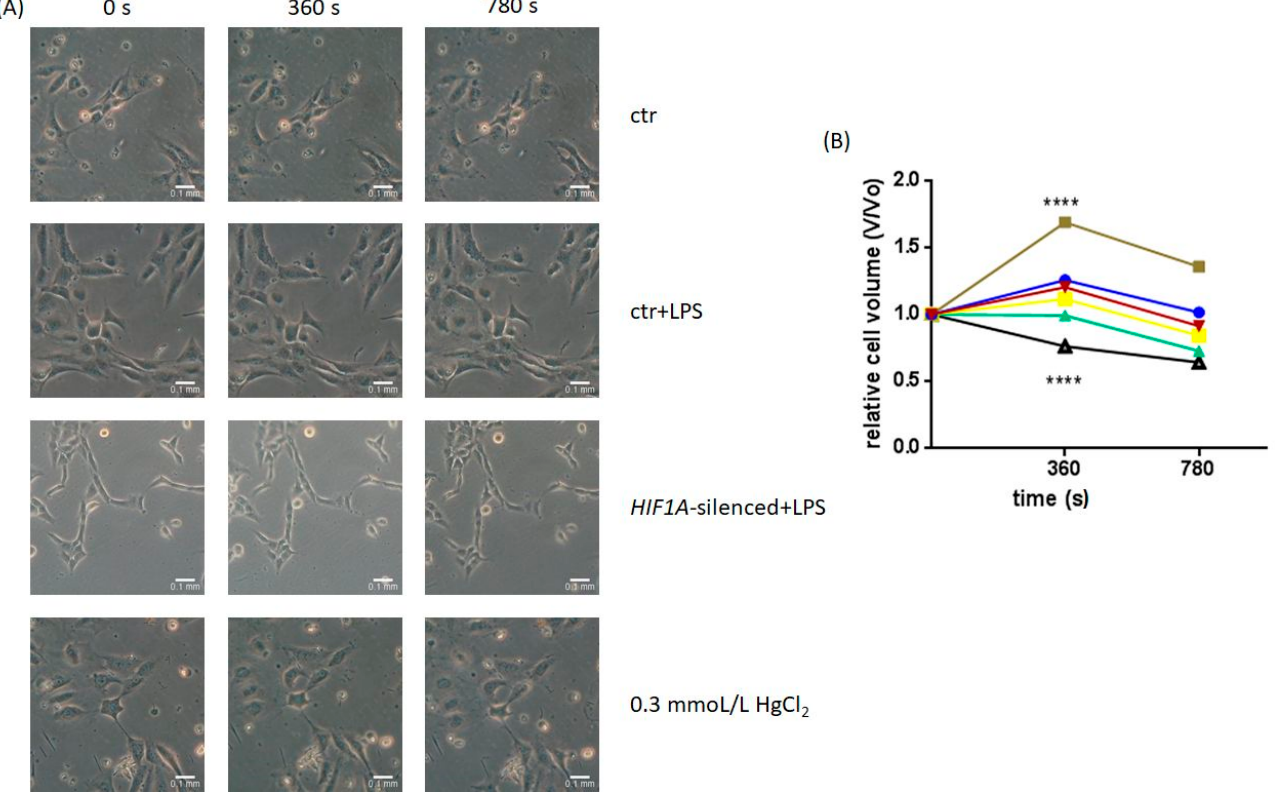
Figure 2. ( A , B ) Time-course of the osmotic swelling of HPMECs. ( A ) Representative images of the osmotically challenged untreated HPMECs (ctr), the LPS-exposed HPMECs (ctr + LPS), HIF1A -silenced HPMECs exposed to LPS, and HPMECs exposed to HgCl 2 , an AQP1 blocker ( B ) Time-course representation of the osmotically challenged untreated HPMECs (blue line with circles), HIF1A -silenced HPMECs (yellow line with squares), the LPS-exposed HPMECs (brown line with squares), HIF1A -silenced HPMECs exposed to LPS (green line with triangles), HPMECs exposed to 0.3 mmoL/L HgCl 2 for 5 min (black line with triangles), HPMECs transfected with a universal scrambled negative control siRNA duplex (red line with triangles). Analysis was performed by 2-way ANOVA followed by Tukey’s posthoc test. ****, p < 0.0001 compared to ctr. Results from 4 independent experiments.